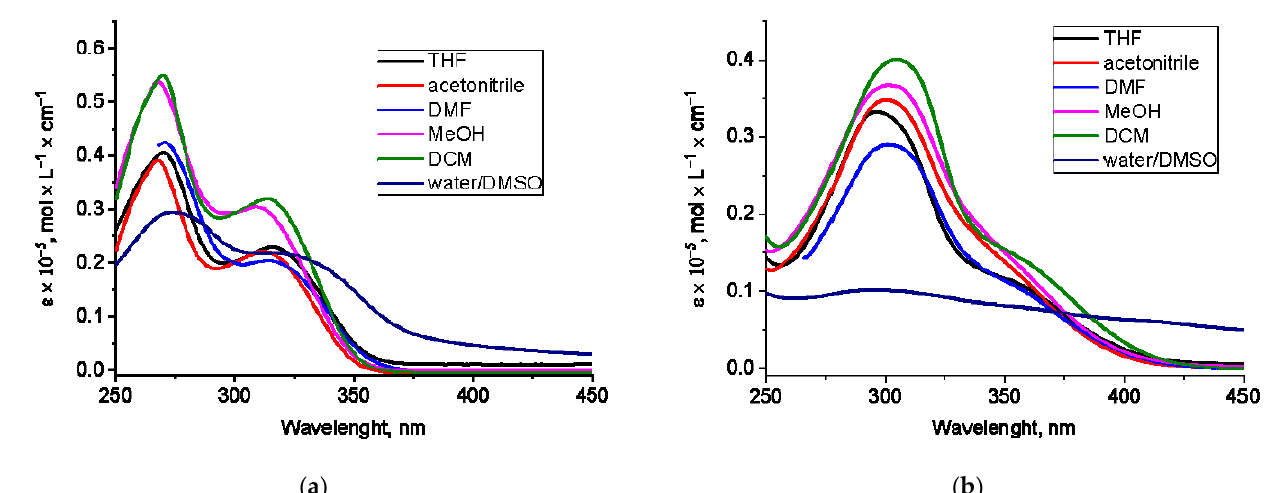
Molecules 2021 , 26 , x FOR PEER REVIEW